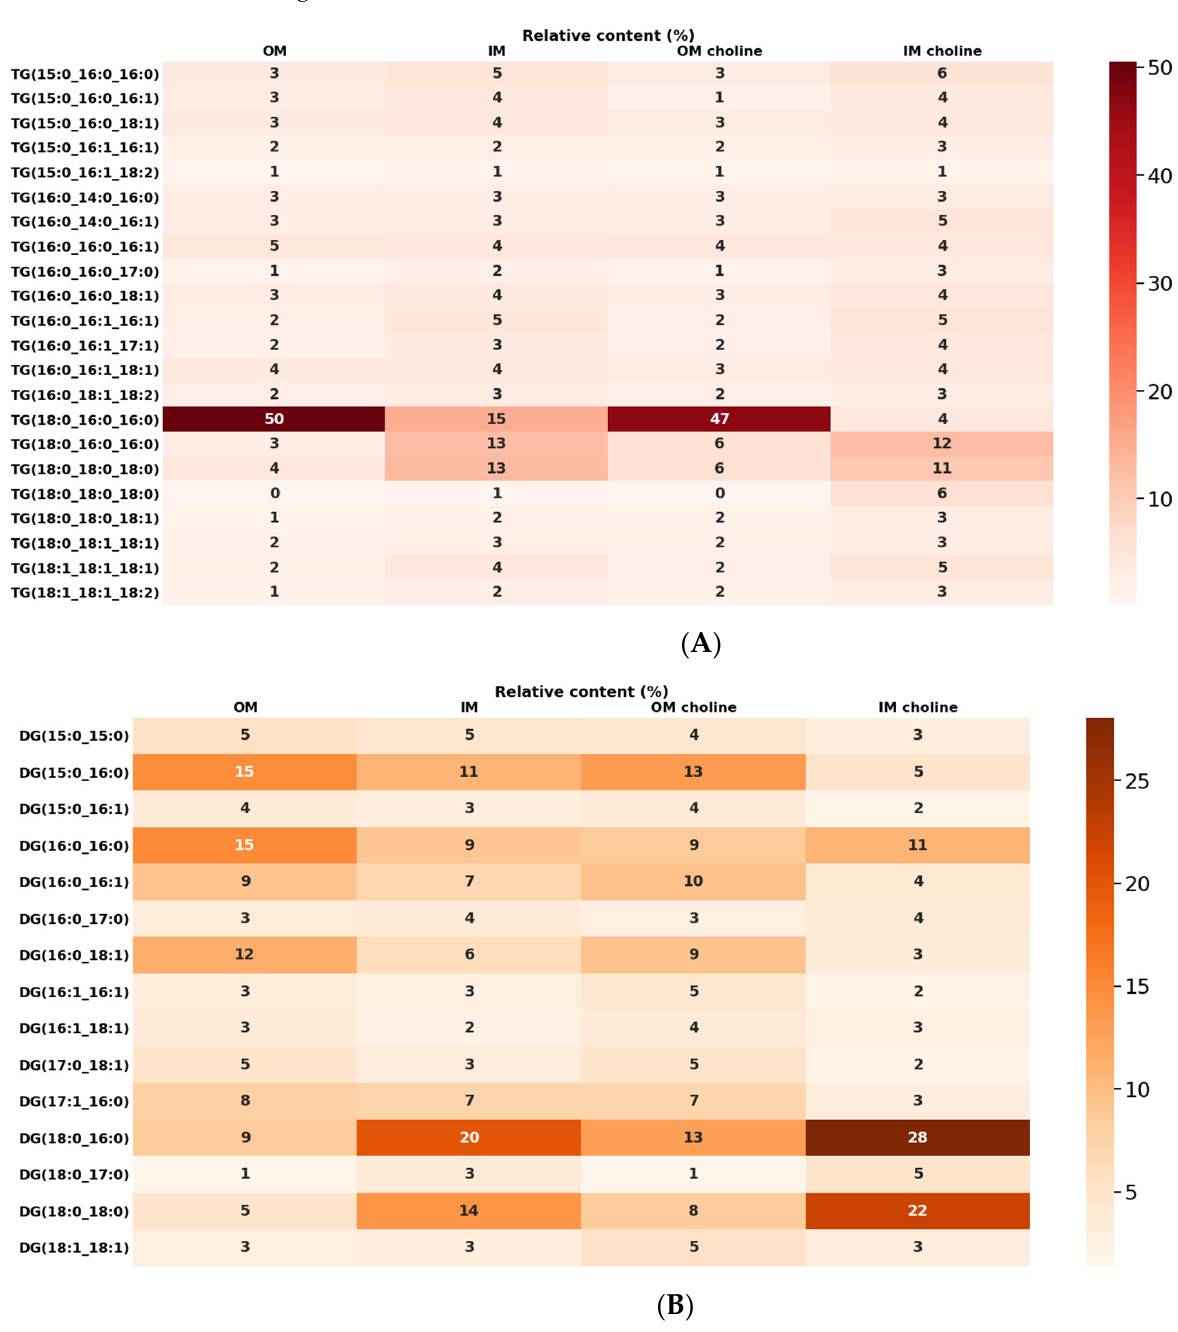
Figure 4. Profile of TG ( A ) and DG ( B ) of the OM and IM of L. gormanii grown on the medium without and with exogenous choline. Lipids were identified via LC-MS(/MS) in the positive ionization